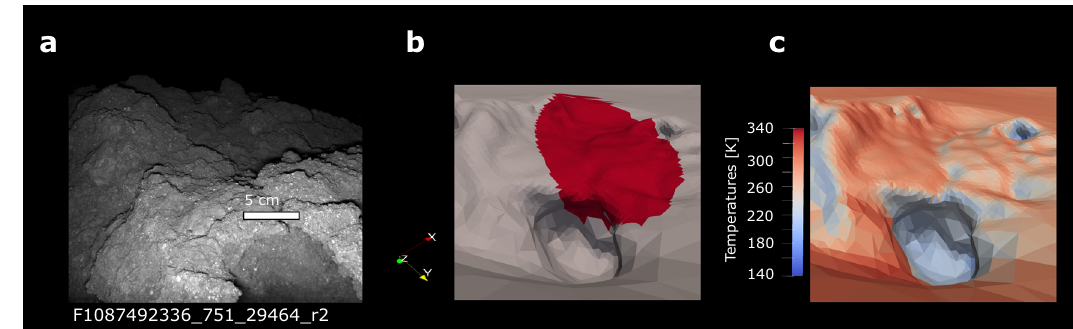
Fig. 1 Images and DEM of the observed boulder. a MASCAM image of the boulder taken during night illuminated by the red LED array of MASCAM 13 . The text below the image denotes the image number. The boulder is of the common, dark, rugged type of boulders on Ryugu. b The DEM of the boulder 37 with the combined fi eld of view of the MARA instrument ’ s six channels shown in red. Axis show the orientation of the DEM within the asteroid ’ s body- fi xed frame for panels b and c . c Same scene as in b overlaid by a snapshot of the thermal model calculation showing the heterogenous temperatures within the MARA fi eld of view due to the boulder